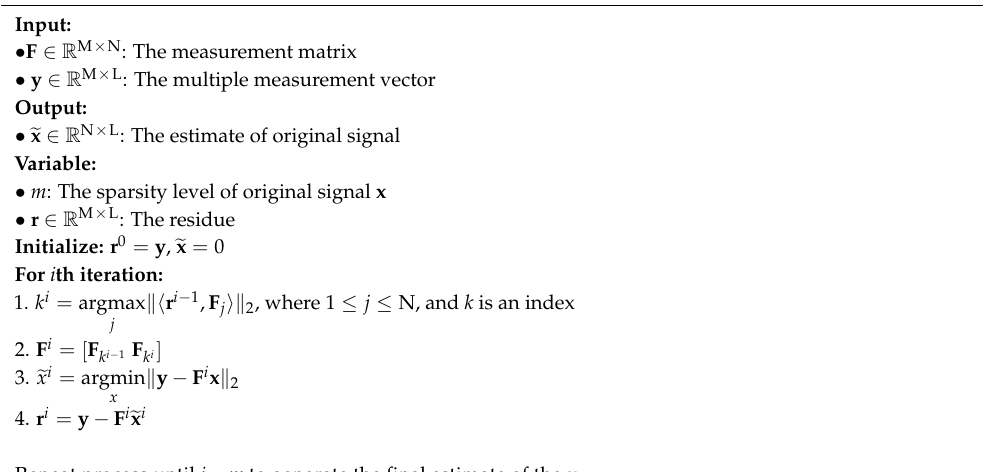
Algorithm 1. Simultaneous orthogonal matching pursuit